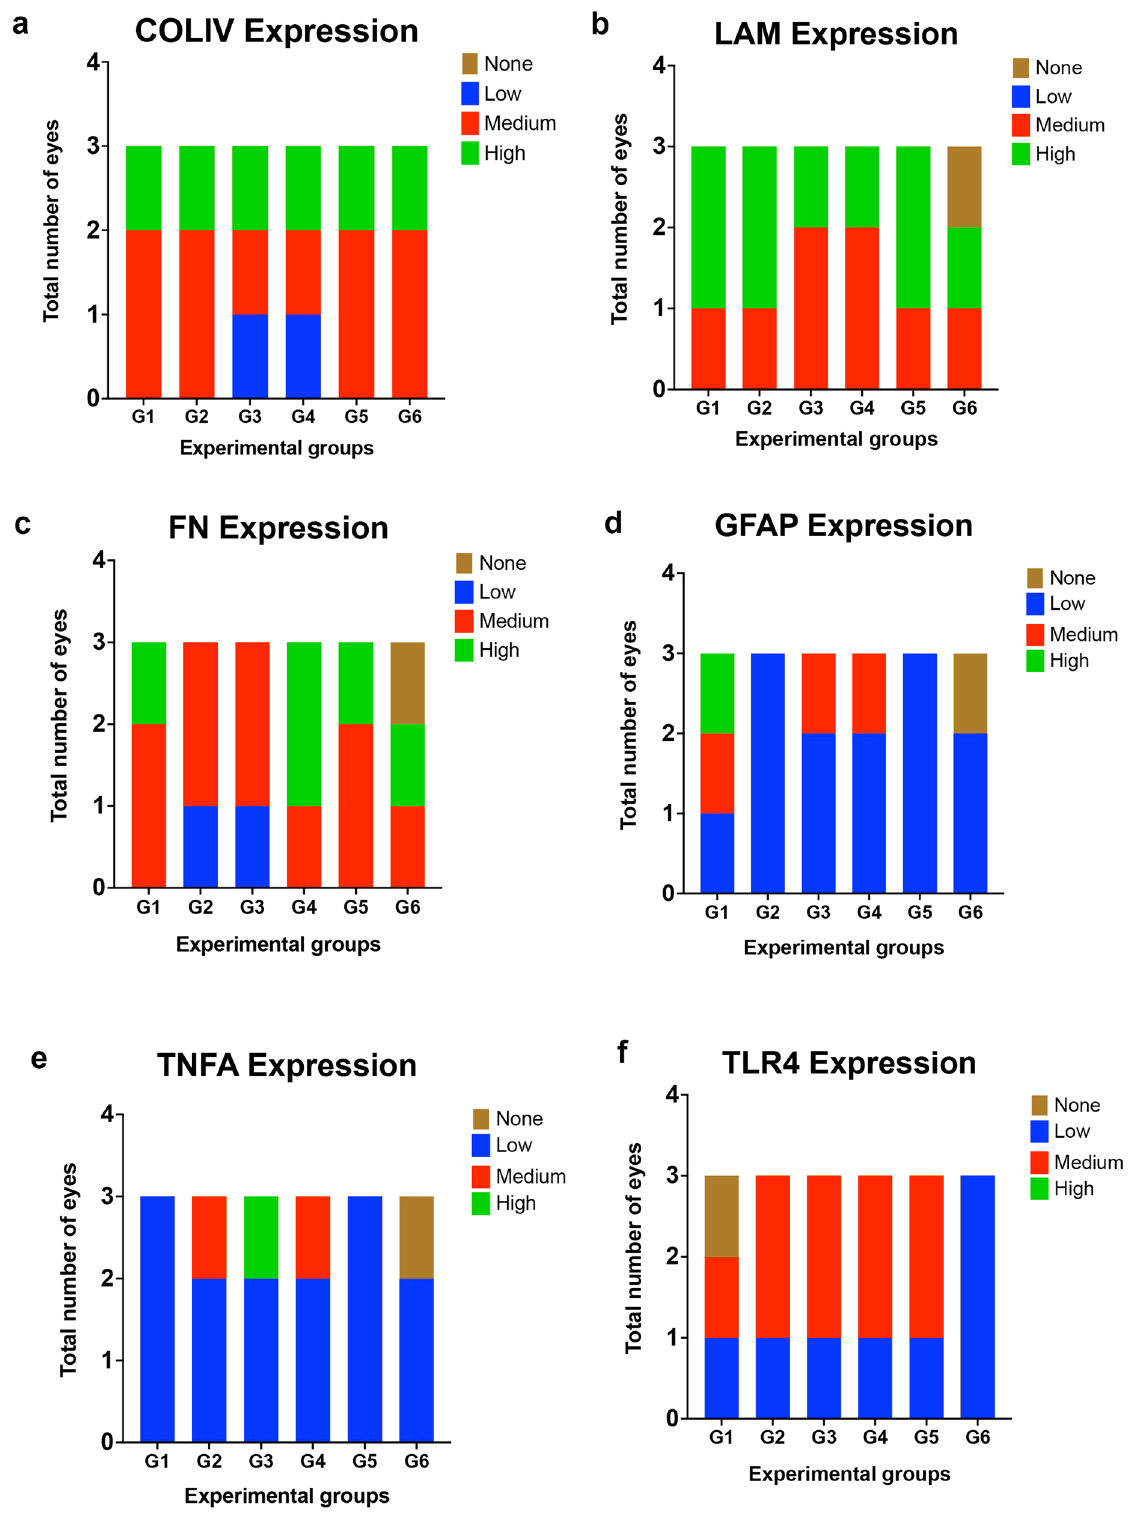
Fig. 7 Expression of in fl ammatory markers at the optic nerve head after perfusion culture. Expression within all groups ( a) COLIV, ( b) LAM, ( c) FN, ( d) GFAP, ( e) TNF α and ( f) TLR4 as graded by blinded observer. Color coding for expression patterns; brown = none, blue = low, red = medium, and green = high, N =